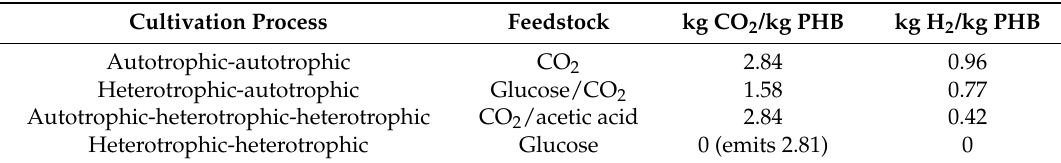
Table 3. Comparison of processes in terms of CO 2 and H 2 consumption based on mass balances (Equations